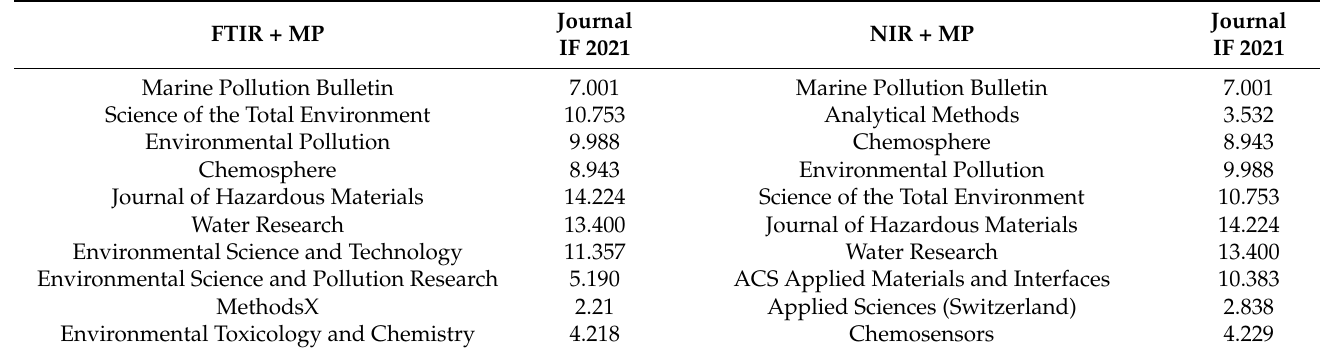
Table 3. List of Top 10 Journals Publishing FTIR- and NIR-related literature.